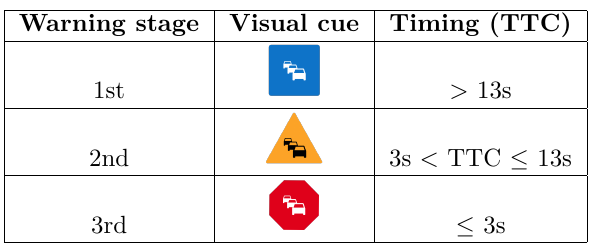
Table 1. TTC threshold for particular warning stages.